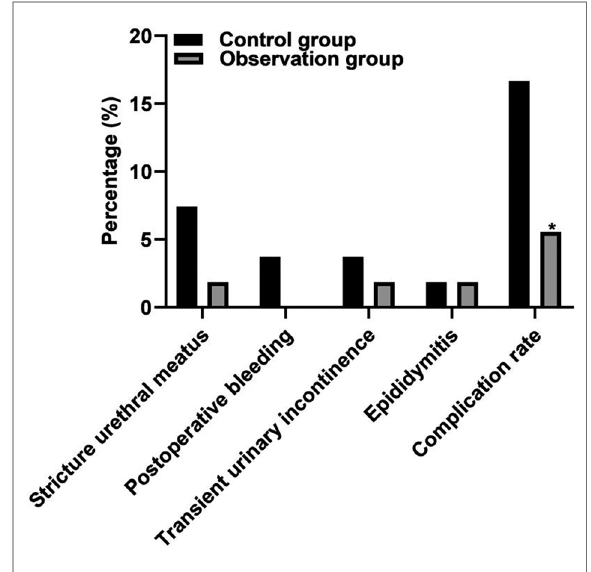
FIGURE 2 Postoperative complications in two groups. Note: Compared with the control group, * P <0.05.